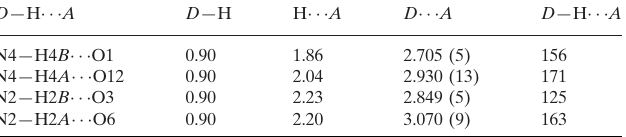
Hydrogen-bond geometry (A˚ , (cid:5)